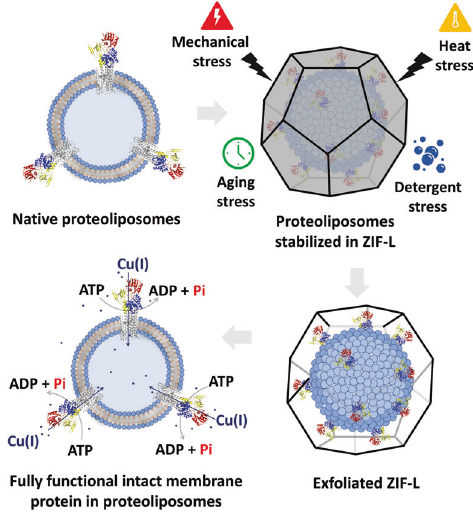
Fig. 1 Proteoliposome stabilization through biomolecular nucleation in ZIF-L. Proteoliposome with CopA embedded cartoon (Top left panel). Proteoliposome encapsulated in ZIF-L cartoon (Top right panel). Removal of ZIF coating from the proteoliposome (Bottom right corner). Recovered, fully functional proteoliposomes cartoon (Bottom left corner). The scheme portrays the process by which the proteoliposome after encapsulation can resist different forms of stress. An exfoliating step is then used to remove the shell and free the proteoliposomes when ready for analysis. Even after intense stressing, catalytic activity of transmembrane copper transporters remains very